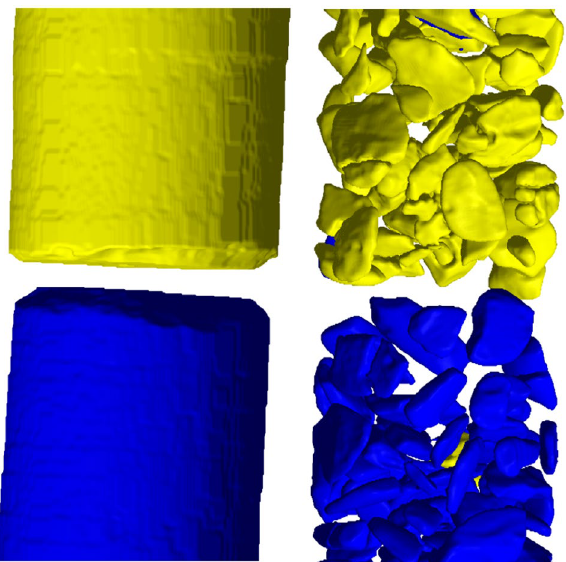
Figure 11. 3D rendering of the AFS-based classification of the disks and separated particles. The yellow and blue colors represent 150 nm and 50 nm pores, respectively.